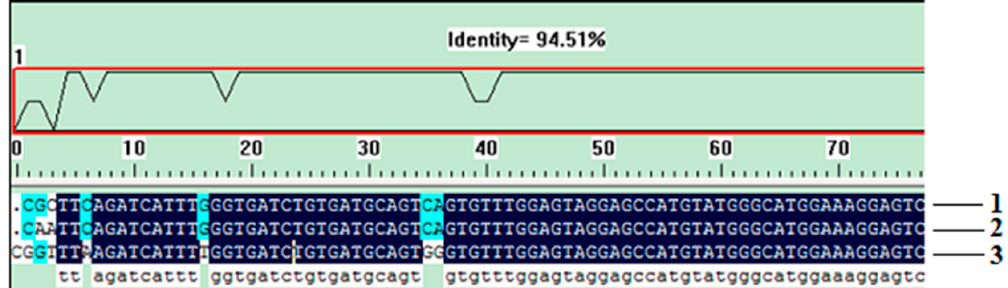
Figure 3. The sequencing result of Pol gene in different samples. 1, Yunnan Shangri-La T. matsutake ; 2, Sichuan Ganzi T. matsutake ; 3, Jilin Yanbian T. matsutak e.